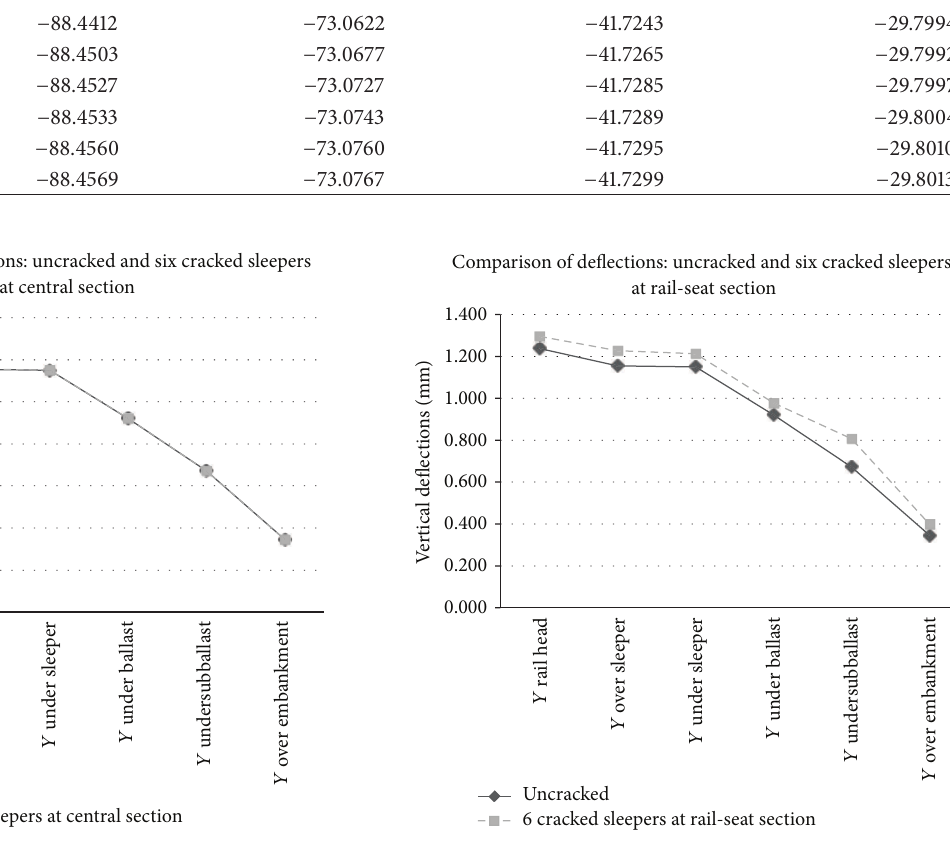
Figure 5: Comparison of deflections (mm) in a track with healthy sleepers and six cracked sleepers at central section.